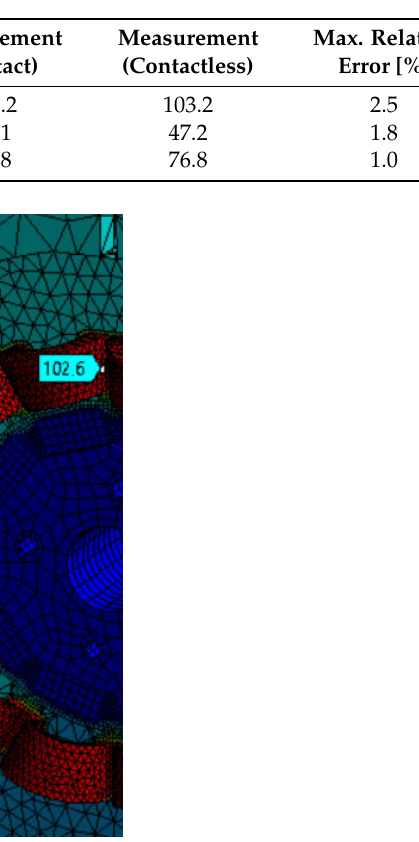
Table 3. Comparison of the calculation and measurement—rotating machine.